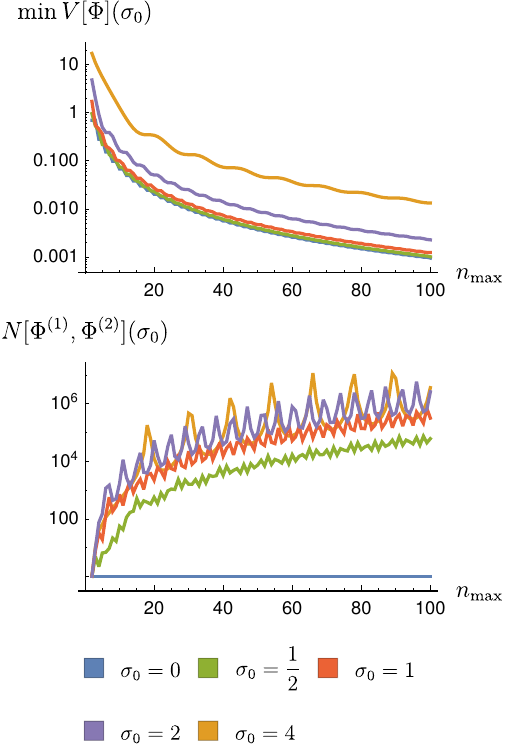
(b) Minimized variance V [Φ] plotted against (a) Minimized variance V [Φ] of the initial data the position σ 0 about which the initial data is norms be- and the ratio N [Φ (1) , Φ (2) ] of L 2 σ S localized. tween the two sides of the black hole, plot- ted against the UV cutoff n max on the source modes. Figure 6. Dependence of the localization of initial data Φ on the UV cutoff n max of the sources and the position σ 0 of